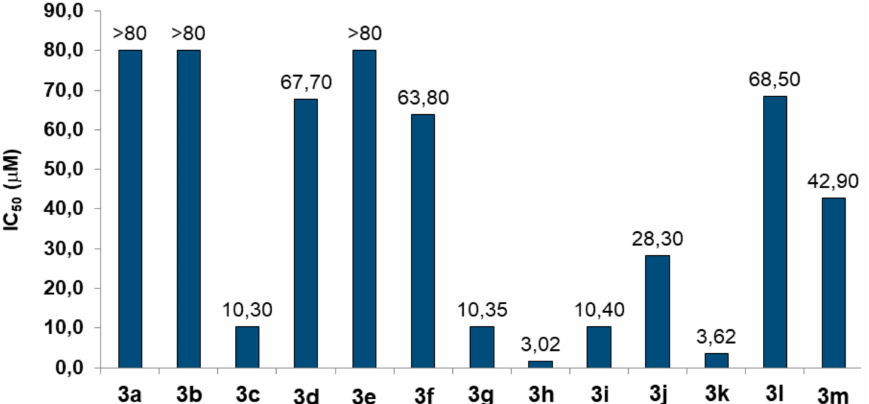
Figure 5. Toxicity of compounds 3a – 3m in neuronal SH-SY5Y cells. Cells were incubated for 24 h with di ff erent concentrations of the compounds (2.5–80 µ M). At the end of incubation, the neuronal viability was measured using MTT assay. Data are reported as IC 50 values (concentration resulting in 50% inhibition of neuronal viability) of the compounds.